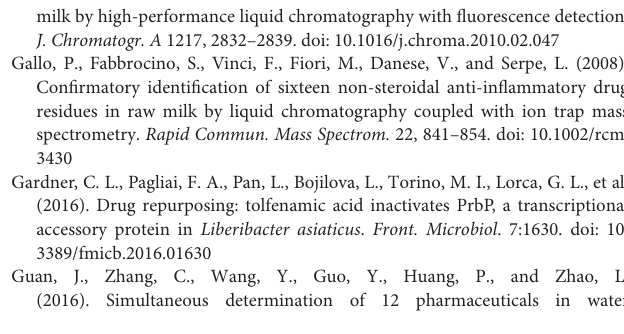
FIGURE S1 | Chromatograms showing the (A) blank, (B) benzbromarone standard (1 µ g/mL) and (C) tolfenamic acid standard (1 µ g/mL) utilizing the developed quantification method. FIGURE S2 | Chromatograms of (A) unspiked, (B) benzbromarone spiked (1 µ g/mL), and (C) tolfenamic acid spiked (1 µ g/mL) matrix, as indicated on the right side of the